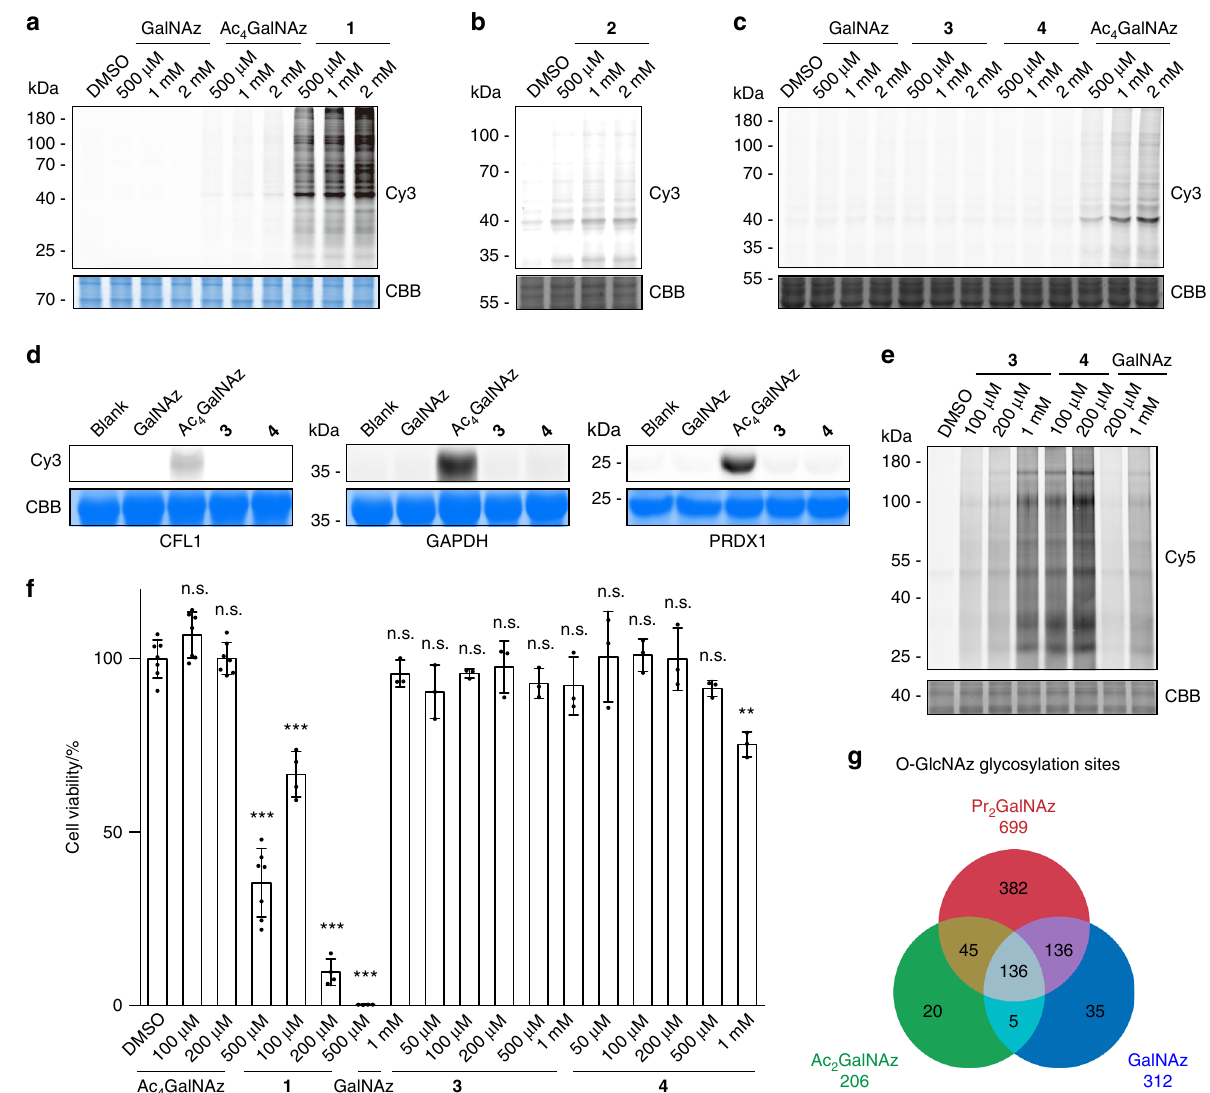
Fig. 2 Labeling ef fi ciency and speci fi city of 1,3-Ac 2 GalNAz and 1,3-Pr 2 GalNAz. a – c In-gel fl uorescence scanning showing HeLa cell lysates treated with respective unnatural monosaccharides at varied concentrations for 2 h, followed by reaction with alkyne-Cy3. d In-gel fl uorescence scanning showing puri fi ed CFL1, GAPDH, and PRDX1 treated with 1 mM of respective unnatural monosaccharides for 2 h, followed by reaction with alkyne-Cy3. e In-gel fl uorescence scanning showing HeLa cells incubated with respective unnatural monosaccharides at varied concentrations for 48 h, followed by reaction with alkyne-Cy5. Coomassie Brilliant Blue (CBB)-stained gels in a – e demonstrate equal loading. In a – e representative results are from three independent experiments. f Cell counting assay by CCK-8 kit showing viability of HeLa cells incubated with respective unnatural monosaccharides at varied concentrations for 48 h. Error bars represent mean ± s.d. Results are from at least three independent experiments (for DMSO and Ac 4 GalNAz, n = 7; for 1 , n = 4; for GalNAz, 3 and 4 , n = 3). ** P < 0.01, *** P < 0.001, n.s., not signi fi cant (one-way ANOVA). g Overlap of O-GlcNAz sites identi fi ed in HeLa cells treated with GalNAz (based on the data set from ref. 8 ), 1,3-Ac 2 GalNAz and 1,3-Pr 2 GalNAz. Source data for fi gures a – f are provided as a Source Data fi